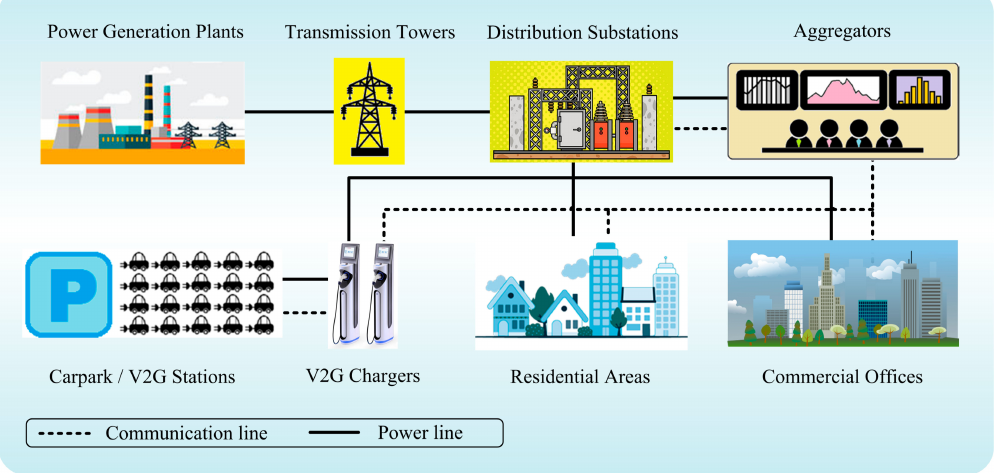
Figure 1. Intelligent Vehicle-to-Grid (V2G)